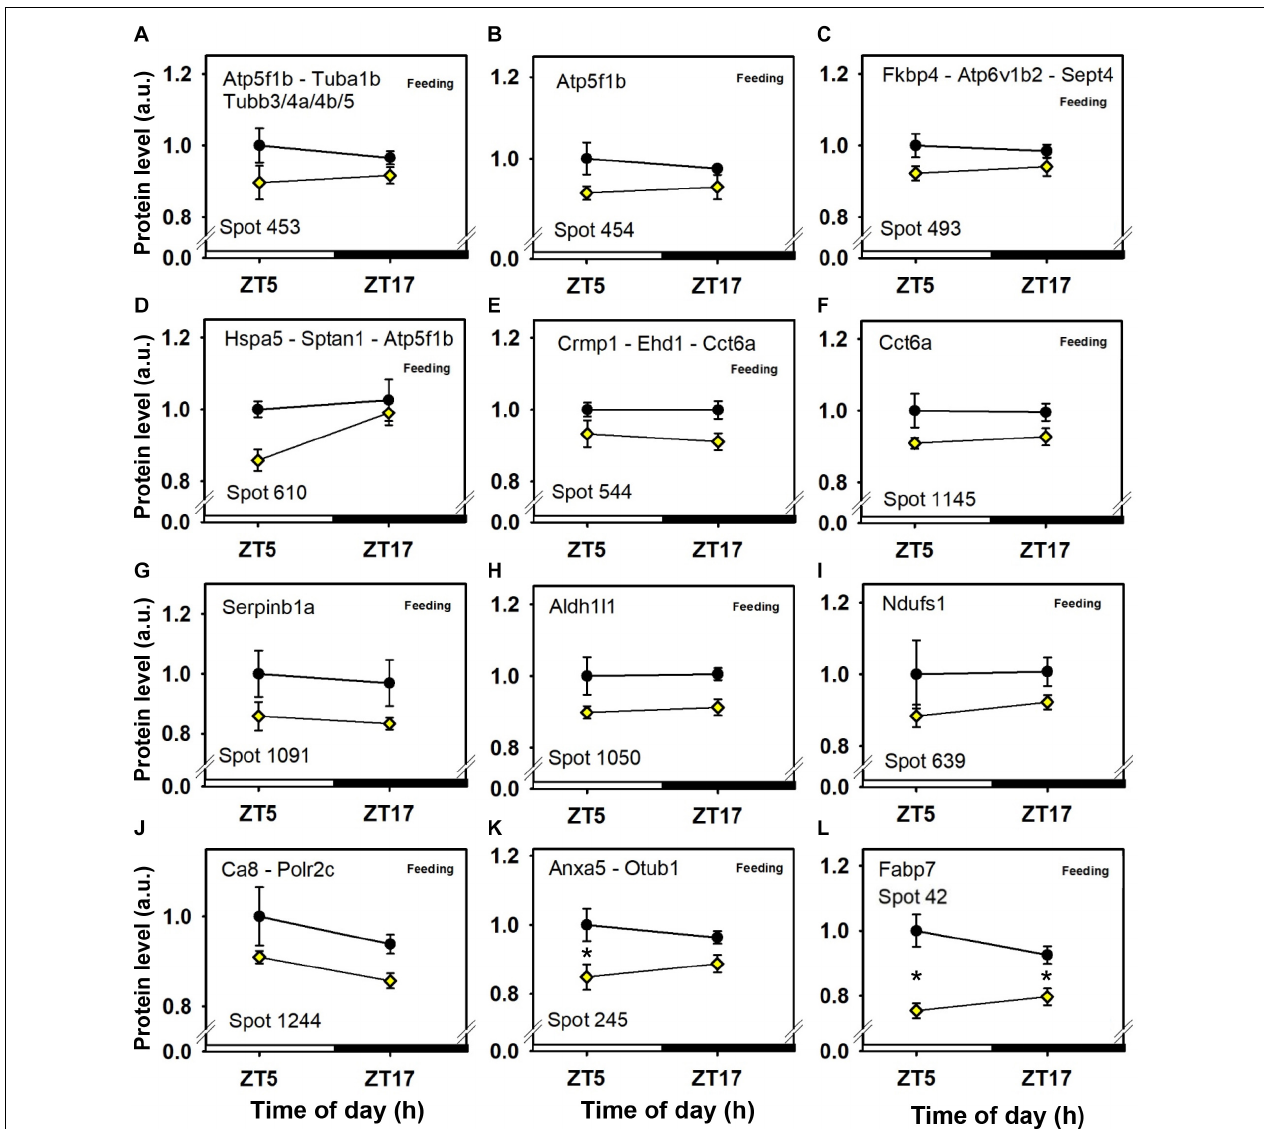
FIGURE 4 | Day–night expression of cerebellar proteins mostly affected by feeding (1/3). From analyses in control mice fed ad libitum (closed circles) and mice exposed to daytime restricted feeding (yellow diamonds), “Feeding” indicates significant ( P < 0.05) main effect of feeding conditions, as detected by two-way